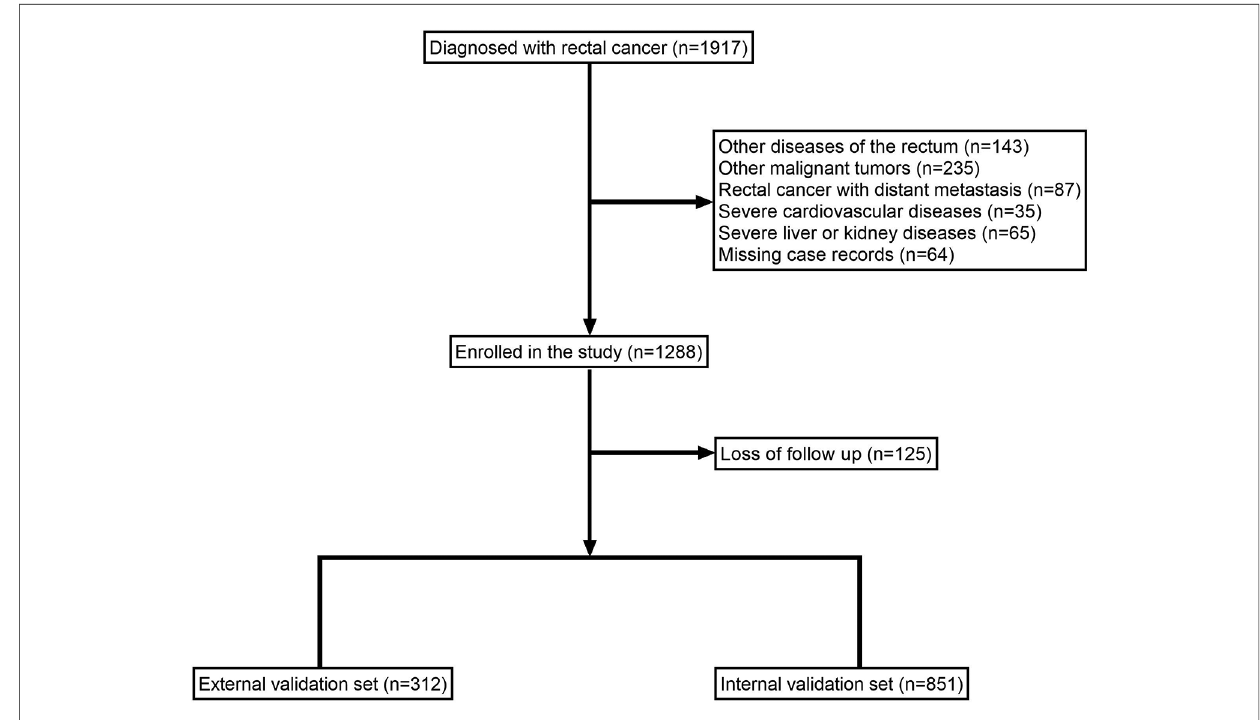
FIGURE 1 Flow diagram of patients included in the